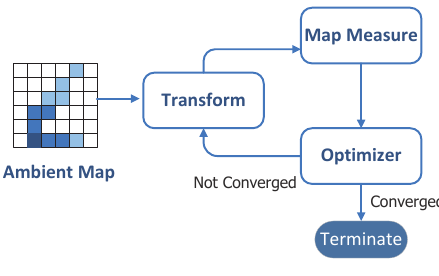
Figure 2. Mechanism